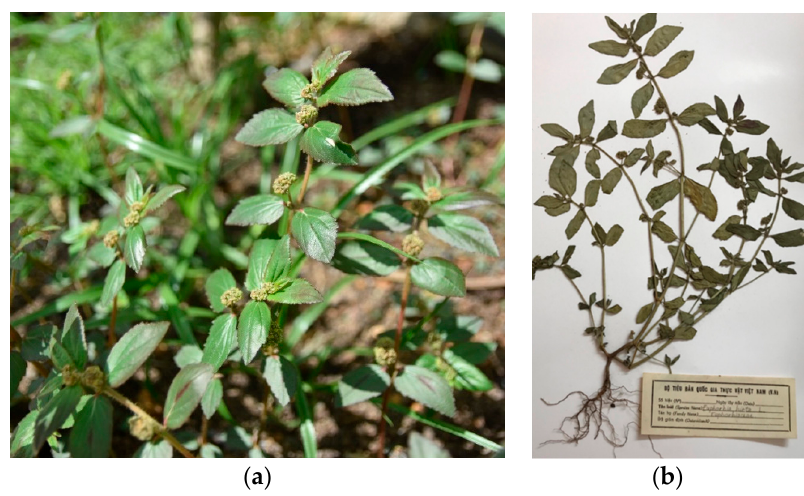
Figure 17. Euphorbia hirta Linn . : ( a ) fresh whole plant and ( b ) plant specimen.